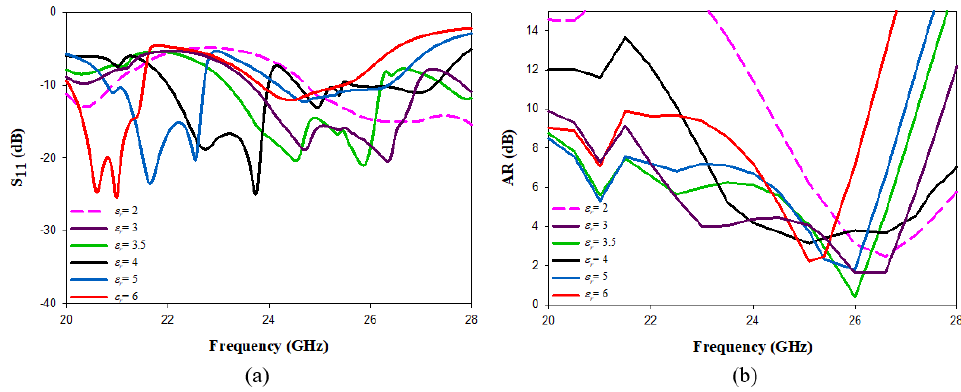
Figure 6. The effect of changing ε r